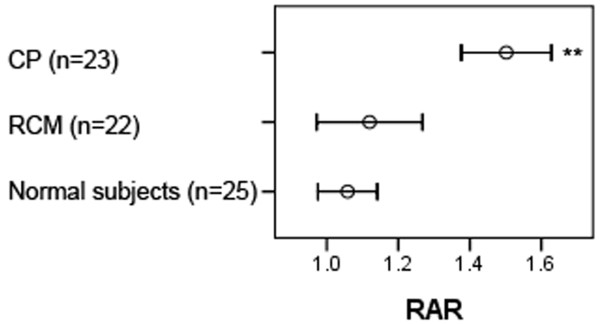
Error bar of the RAR. Data are presented as means (squares) and 95% confidence interval (whiskers). **p < 0.001.